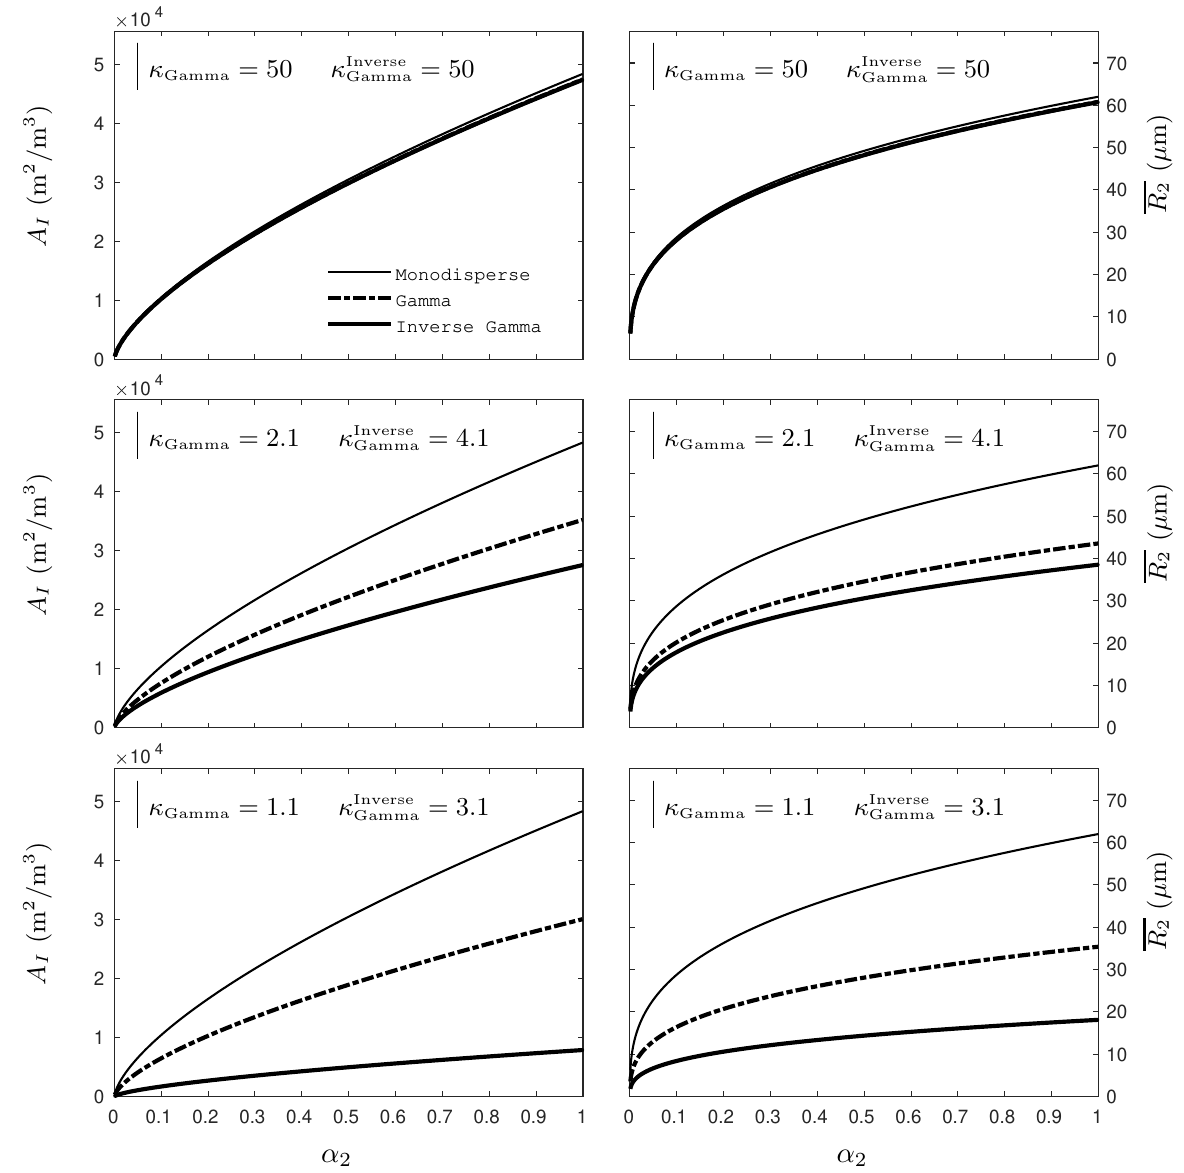
Figure 3: Comparison of the interfacial area A I and mean radius R 2 , in the monodisperse and polydisperse situations, for various liquid volume fractions α 2 . The specific number of droplets N 2 is constant and is set to N 2 = 10 12 droplets per unit volume. For the monodisperse situation, A I and R 2 are computed via Eq. (4.30). For the polydisperse situation, A I and R 2 are computed via Eq. (4.31).